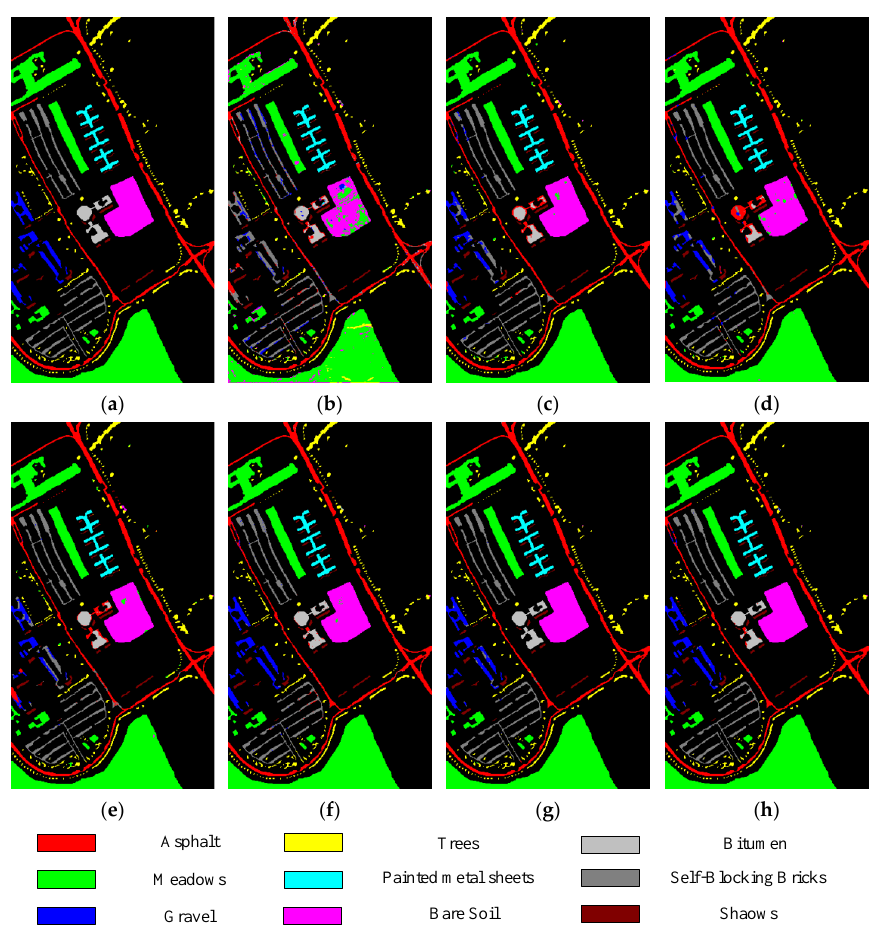
Figure 6. Classification diagrams of UP datasets obtained by seven methods: ( a ) the ground truth, ( b ) SVM-RBF, ( c ) DRCNN, ( d ) ROhsi, ( e ) SSAN, ( f ) SSRN, ( g ) A 2 S 2 K-ResNet, and ( h ) DSSIRNet.